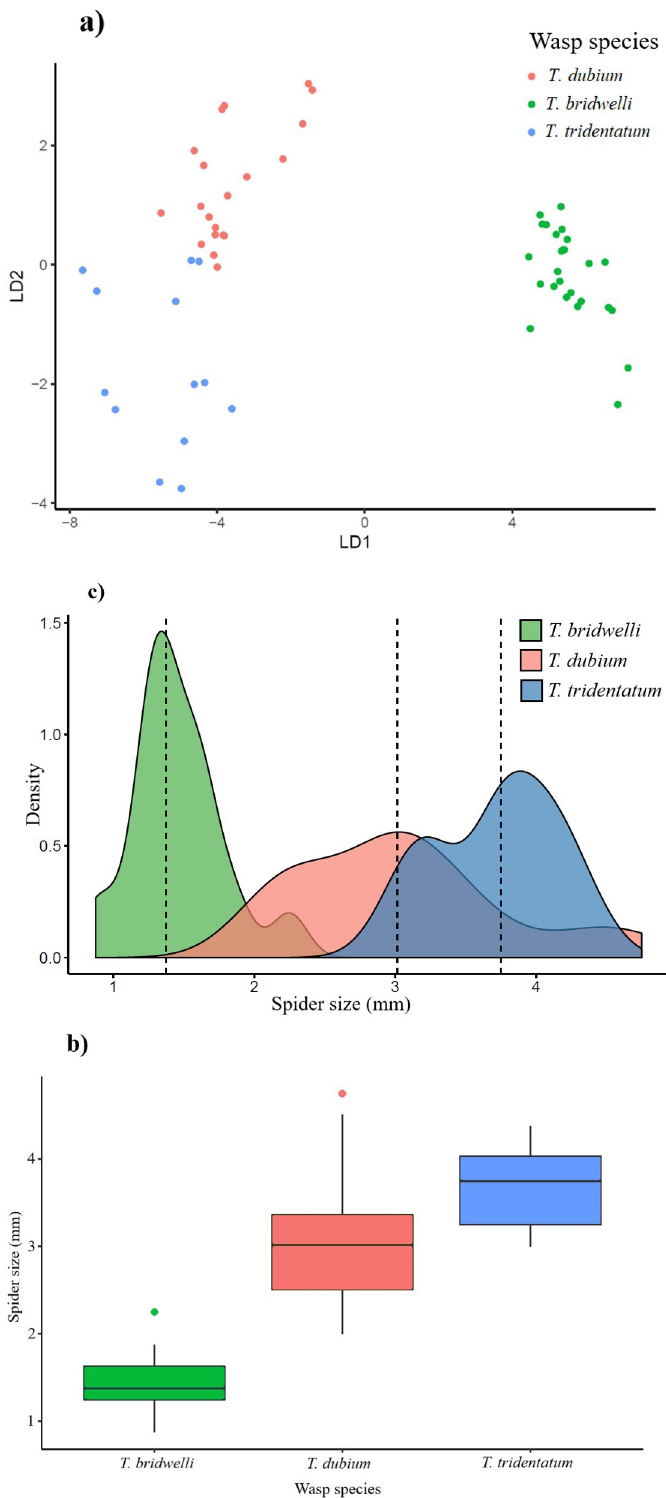
Fig 8. Morphological differences associated to prey selection. a) Differences in body size between the three wasp species, b) differences in spider prey size and c) range of prey size chosen by each Trypoxylon species. Dashed lines indicate the